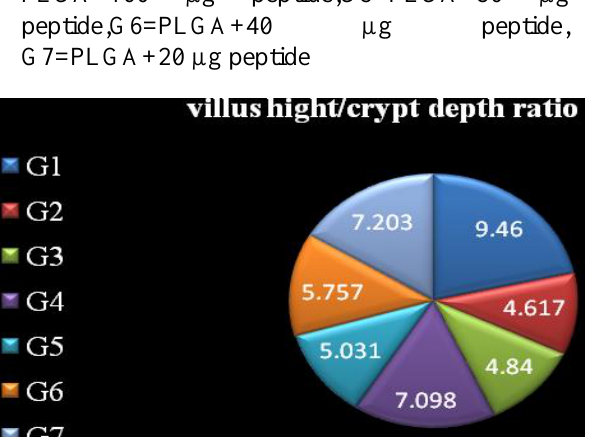
Figure 3. Effect of PLGA Npsand PLGA loaded with different concentration of peptide on crypt depth(µm). G1=received diH2O, G2= ordinary vaccine,G3=PLGA